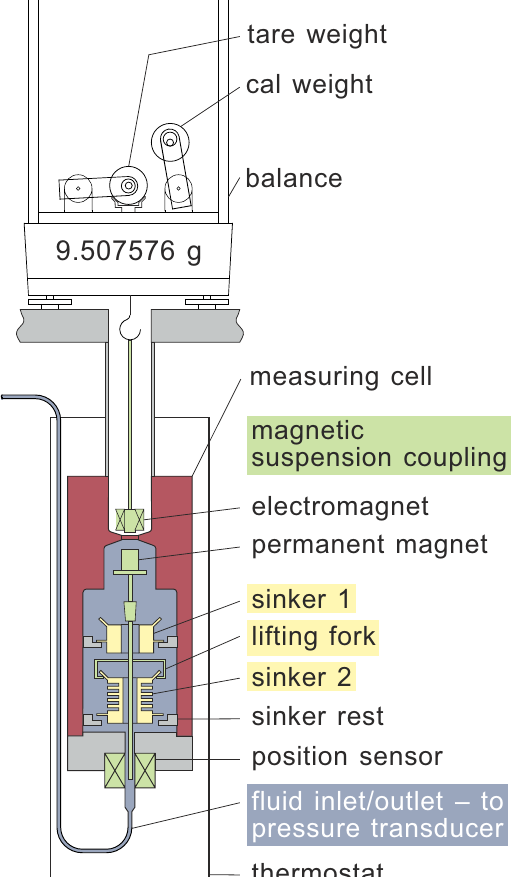
Figure 6. Simplified schematic diagram of the NIST two-sinker densimeter. Sinker 1 is the density sinker, and sinker 2 is the sorption sinker. The sinkers are weighed through a magnetic-suspension coupling comprising an electromagnet, a permanent magnet and a position